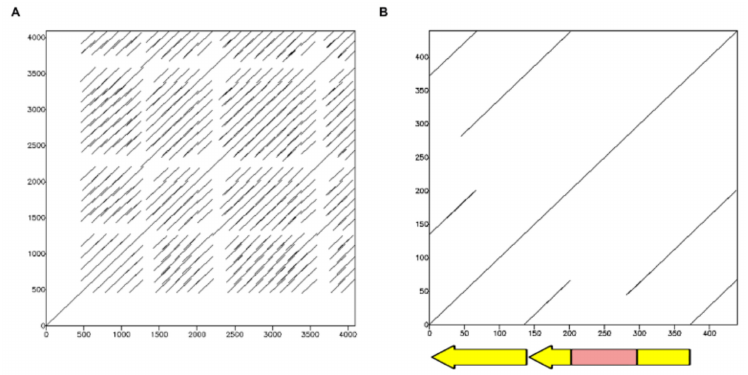
Figure 2. ( A ) Dotplot of a region of a R. prolixus superconting that shows similarity with the Tinf33-372 satDNA of T. infestans . The superconting contains several tandems of repeats of about 135 bp in length; ( B ) Dotplot of one of the cluster for TinfSat33-372 obtained in the RepeatExplorer analysis of the T. infestans genome. The 372 bp repeat contains two internal repeats of about 135 bp (arrows) and an unrelated sequence of about 100 bp (box).